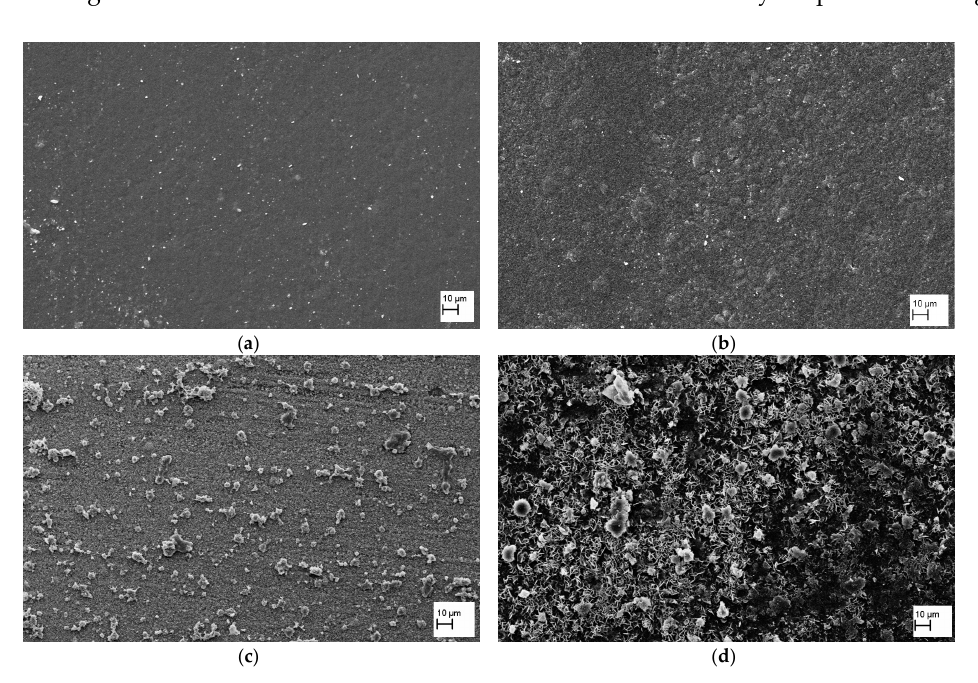
Figure 8. Optical microscope images of PURs-M after ( a ) and after 15 days of short-term interactions study performed in the selected environments: basic ( b ); acidic ( c ); and oxidative ( d ).